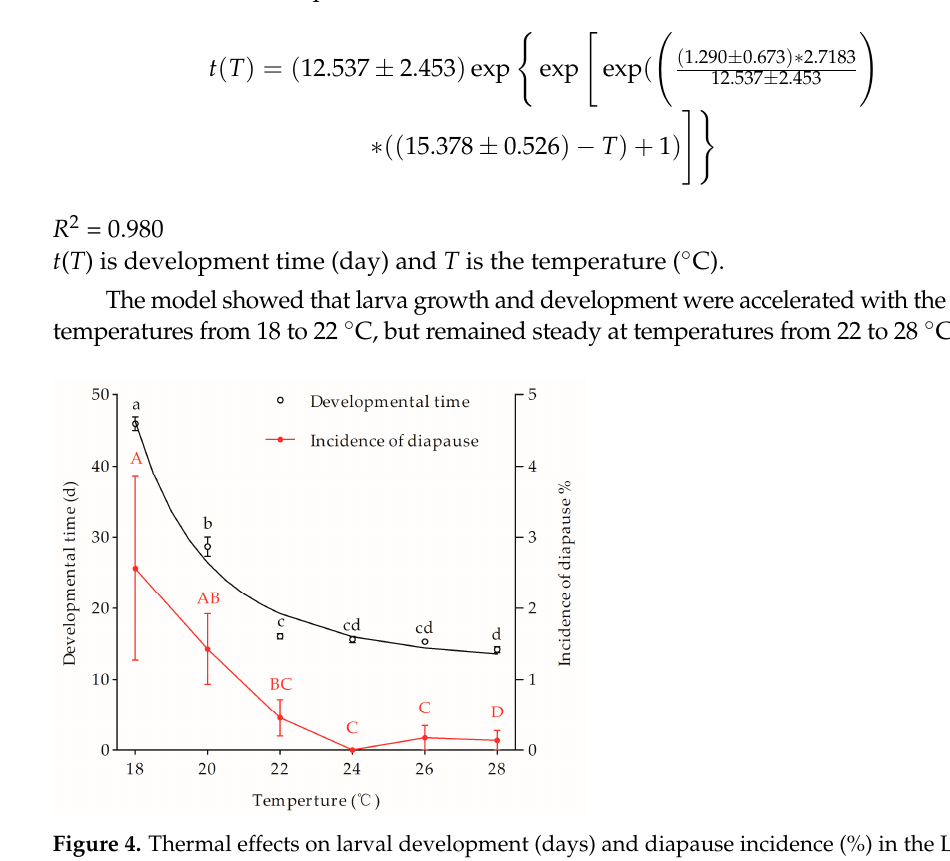
Figure 3. Photoperiodic response of Lm under a diapause inducing temperature (28 °C). Symbols and bars represent the mean ± SE values. Different uppercase letters indicate significant differences ( p < 0.05) among diapause incidence of the photoperiodic response of Lm strain.